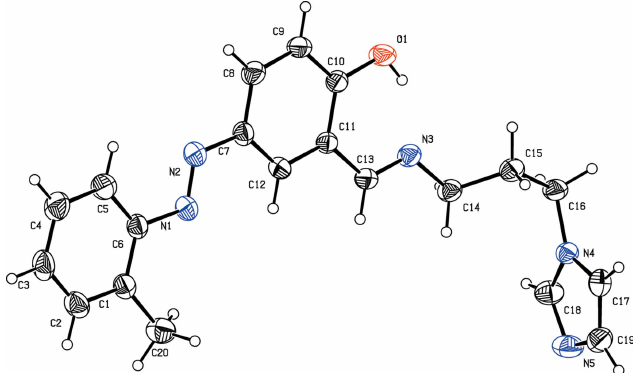
Figure 1 The structure of the title compound, showing the atom-labeling